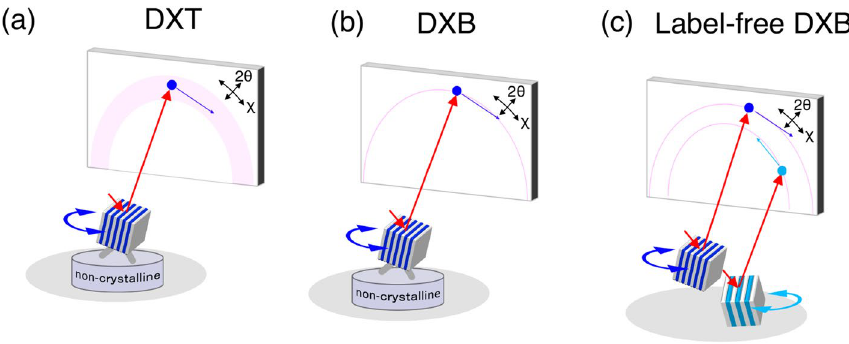
Figure 1. Diffracted X-ray Tracking (DXT) and Diffracted X-ray Blinking (DXB). Schematic illustration of ( a ) DXT, ( b ) DXB and ( c ) label-free DXB for crystalline